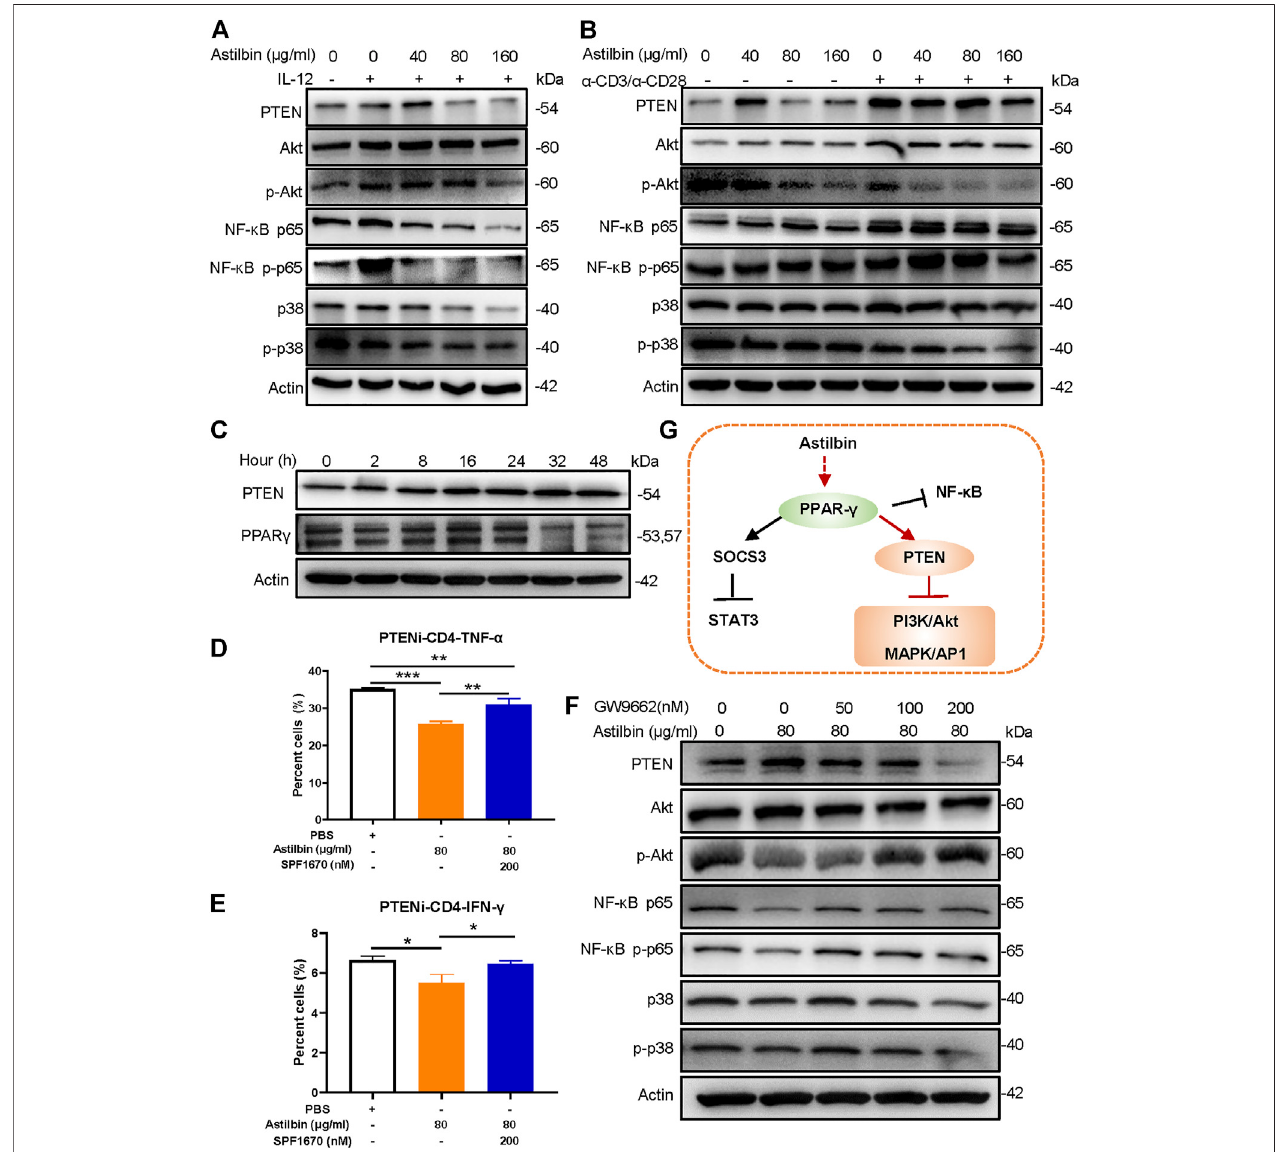
FIGURE 3 | PPAR γ /PTEN pathway in astilbin-treated CD4 + T cells. Effects of astilbin on the expression of PTEN, Akt/p-Akt, NF- κ B p65/NF- κ B p-p65, and p38/ p-p38 of unstimulated, IL-12- (A) , or α -CD3/ α -CD28 − (B) stimulated CD4 + T cells by Western blot analysis. (C) Effects of astilbin (80 μ g/ml) on PTEN and PPAR γ of CD4 + T cells at different time points. Effects of PTEN inhibitor (SF1670) on TNF- α (D) and IFN- γ (E) production in astilbin-treated CD4 + T cells. Mean ± SD; n = 3. (F) Effects of GW9662 on PTEN, Akt/p-Akt, NF- κ B p65/NF- κ B p-p65, and p38/p-p38 of astilbin-treated CD4 + T cells. (G) Diagram of PPAR/PTEN pathway on CD4 + T cells by astilbin. Each experiment was conducted at least three times. The inhibitor of PTEN, SF1670 is abbreviated as PTENi. p values (* p ≤ 0.05; ** p ≤ 0.01; *** p ≤ 0.001) determined by one-way ANOVA (D,E) .